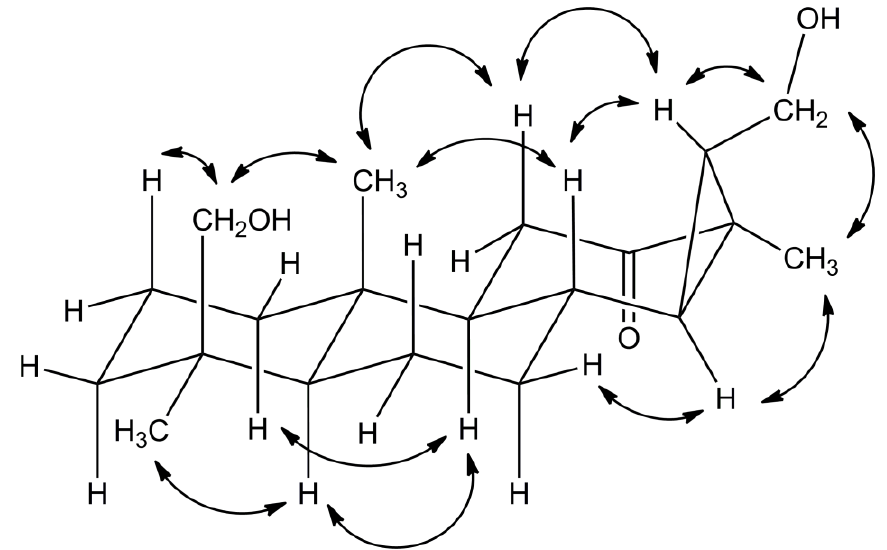
Figure 2. Important NOESY correlations observed for compound 1 .